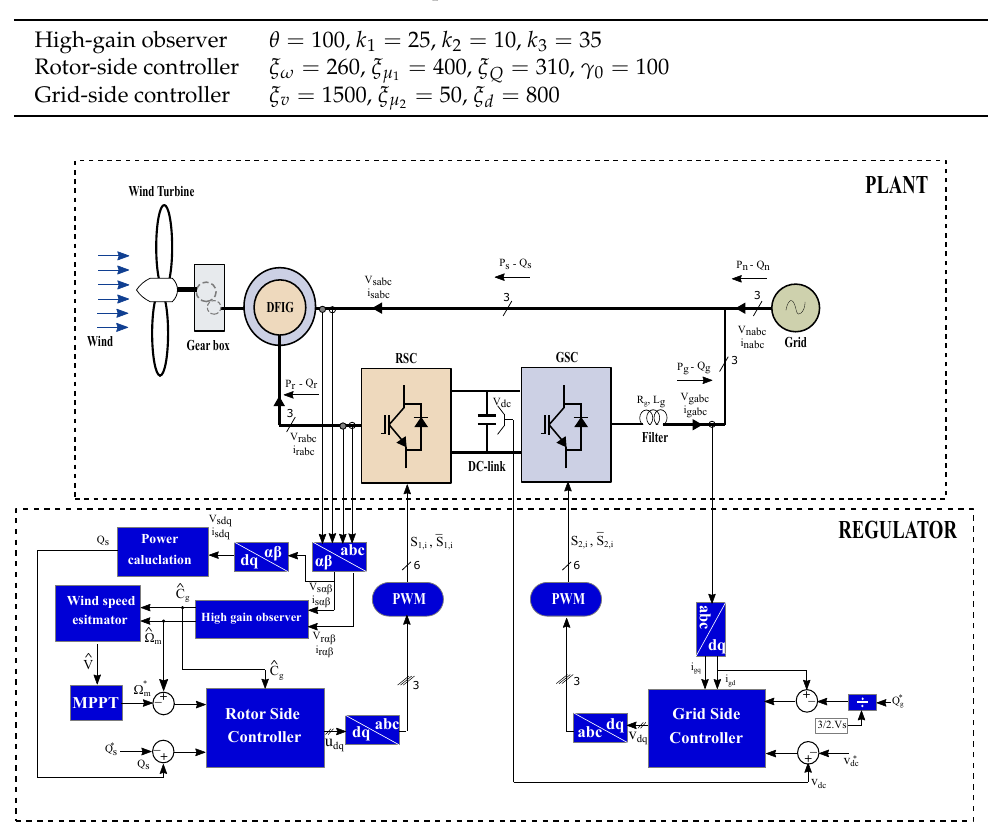
Figure 9. Controller design of the global studied